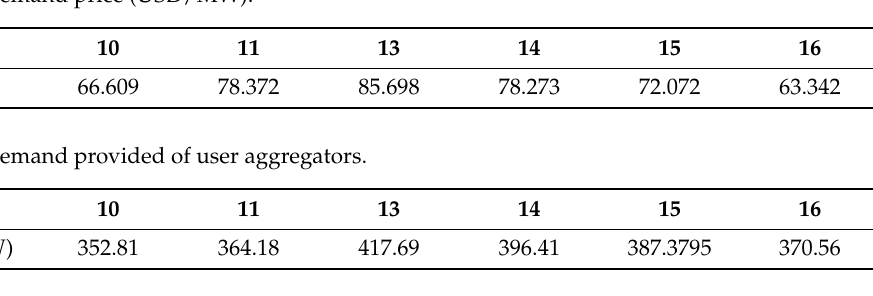
Table 1. Demand price (USD/MW).